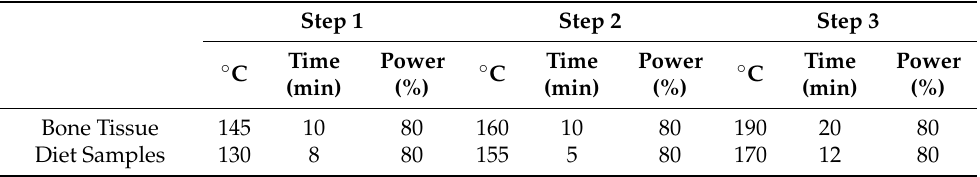
Table 2. Three-step microwave digestion